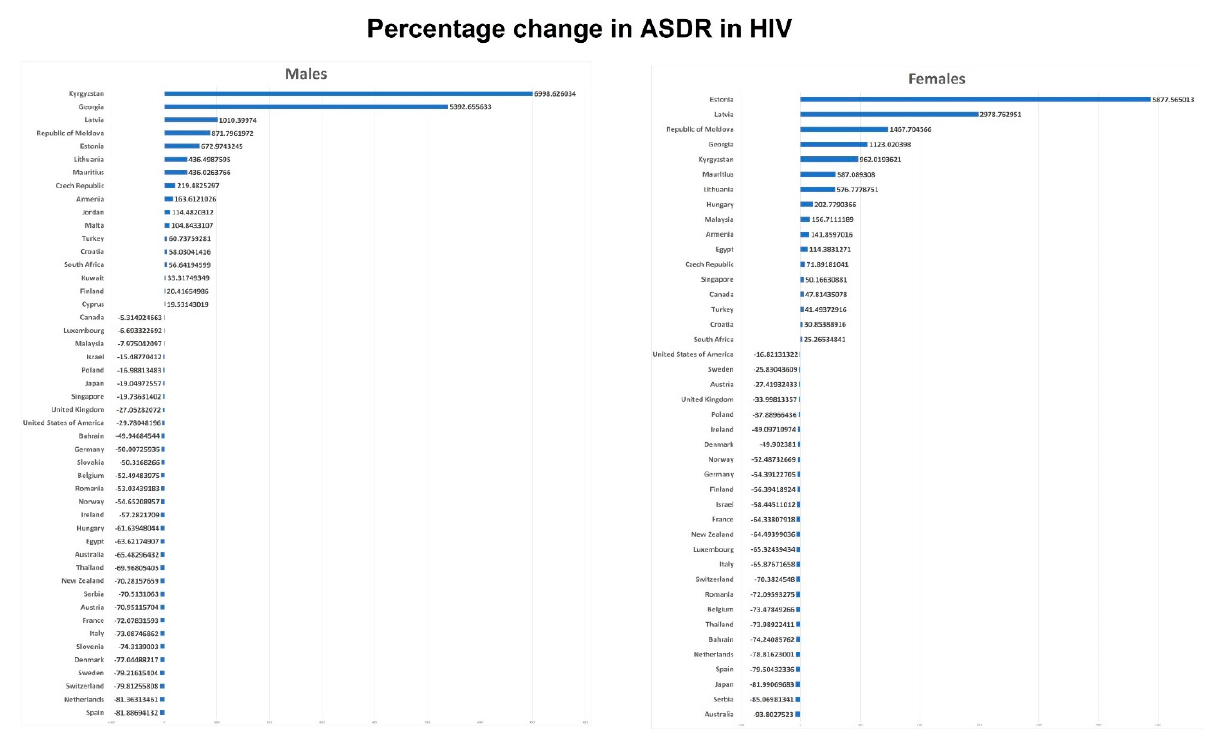
Figure 3. Percentage changes in age-standardized death rate in males and females. Region-wise, in the Americas, positive PCs were observed in Canadian females (+47.81%) between 2001 and 2005, with a positive AC (1.74). Whereas males had a re- duction ( − 5.31%) in PC and ( − 1.06) AC. In the USA, males had − 29.78% PC and − 19.95 of AC, whereas females had − 16.82% PC and − 3.85 of AC between 2001 and 2007. In Europe, the maximum positive PC was observed in Kyrgyzstan for males (+6998.63% between 2002 and 2016), while Latvia had the highest positive AC for males with a value of 52.69 (between 2001 and 2015). For females, Estonia had the highest positive values for both PC and AC (+5877.57% and +26.95, respectively between 2001 and 2016). The maximum negative PC and AC values were observed in Spain for males ( − 81.89% and − 46.29, respectively between 2001 and 2017). In females, the highest PC was found to be in Serbia ( − 85.01% between 2001 and 2017), whereas that of AC was in Romania ( − 15.71 between 2001 and 2017). For males, 21 (61.8%) countries showed decreased PC and AC in ASDR during our study period. Armenia, Croatia, Czech Republic, Estonia, Finland, Latvia, Malta, Turkey, Georgia, Kyrgyzstan, Lithuania, Republic of Moldova, and Cyprus increased in PC and AC in ASDR in males. Out of 30 European countries with available data for females, 19 (63.3%) showed decreasing PC and AC. In contrast, positive PCs and ACs were observed in Armenia, Croatia, Czech Republic, Estonia, Hungary, Lat- via, Turkey, Georgia, Kyrgyzstan, Lithuania, and the Republic of Moldova. In the Western Pacific region, the overall mortality percentage changes and the abso- lute changes in ASDR in males were negative in all countries. The largest PC was observed in New Zealand ( − 70.28% between 2001 and 2017) and the smallest in Malaysia ( − 7.97% between 2007 and 2014). For AC, the largest negative change was seen in Australia ( − 6.49 between 2001 and 2017). In females, the highest positive PC and AC values were in Ma- laysia (+156.71% and +2.31, respectively from 2007 to 2014), and the highest negative PC and AC values were in Australia ( − 93.80% and − 1.04, respectively between 2001 and 2017).